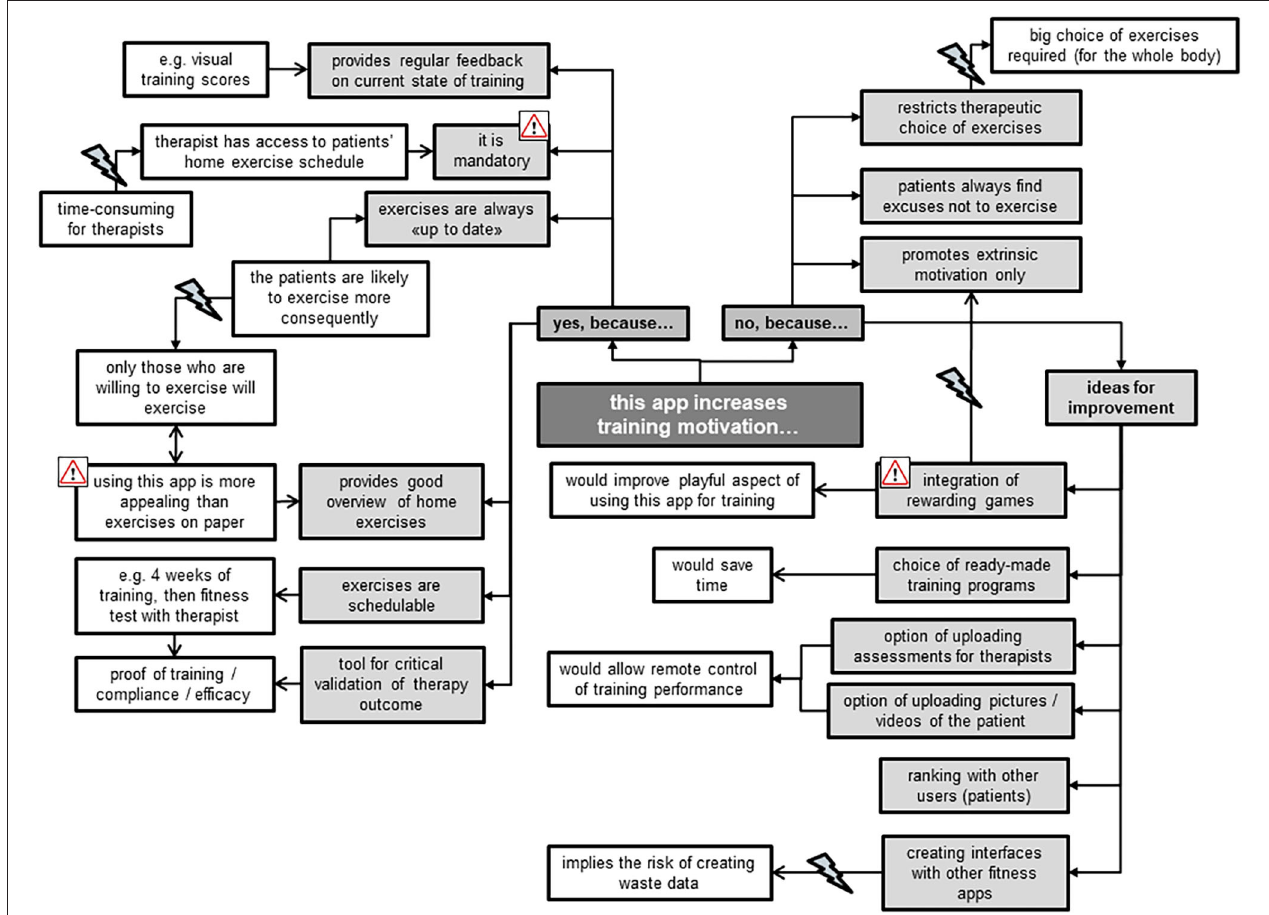
FIGURE 6 | Therapists’ statements about perceived training motivation when using the Fit app for their